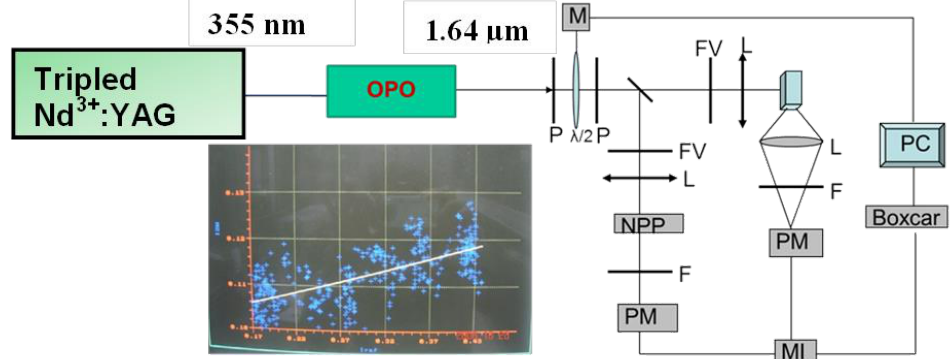
Figure 5. A schematic diagram of HRS measurement at 1.64 µm. F: Filter; M: Mirrors; A: Attenuator; GP: Glass plate; L: Lens; P: Polarizer; λ / 2: Half wave plate; PMT: Photomultiplier tube; NPP ( N -4-nitrophenyl-prolinol): Reference material.